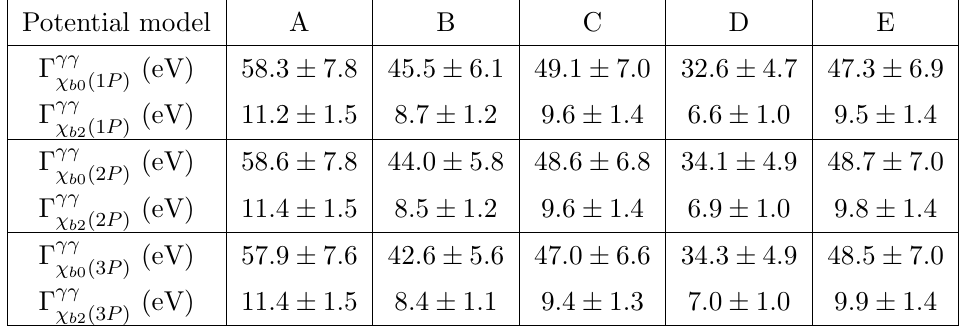
Table 8 . Results for the two photon decay widths of the states (cid:31) b 0 ( nP ) and (cid:31) b 2 ( nP ), indicated with (cid:0) (cid:13)(cid:13) and (cid:0) (cid:13)(cid:13) respectively, for each of the potential models described in section (cid:31) c 0 ( nP ) (cid:31) c 2 ( nP )